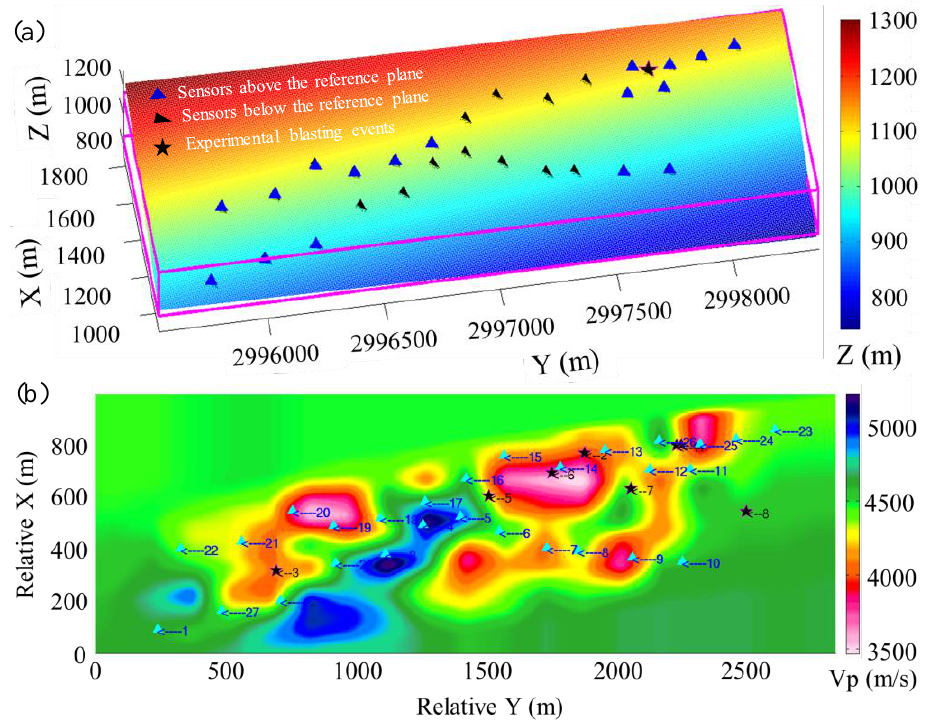
Figure 8. 3D spatial location of the 2D slice in tomographic velocity model and 28 sensors and experiment blasting events in the Yongshaba mine. ( a ) The 2D velocity slice is defined by the plane with the smallest projection distance to all sensors, and the origin of the relative plane coordinates corresponds to the coordinate point in the lower left corner. The positive Z direction is vertically upward, while the X and Y directions are respectively along the north and east. Colorbar represents the elevation of the 2D slice in 3D coordinates. The blue triangle represents those locations of sensors that are actually above the 2D slice, while the black triangle indicates the locations of a sensors that are below the slice. Black stars are the projection locations of the eight experiment blasting events onto the 2D slice. ( b ) The 2D velocity model view corresponding to the 2D spatial slice. It is obtained through interpolation of the high-resolution 3D P-wave velocity model of Wang et al. [65]. The numbers beside the cyan color triangles and the black stars correspond to the index of the sensors and the blasting events projected onto 2D slice.